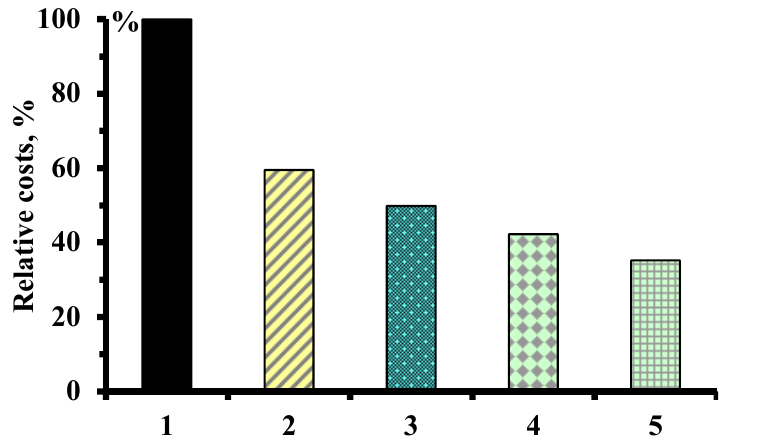
Figure 7. Relative costs (1—DPP, 2—DPP + PV, 3—DPP + WT, 4—DPP + GPP, 5—DPP + WT + PV + GPP).